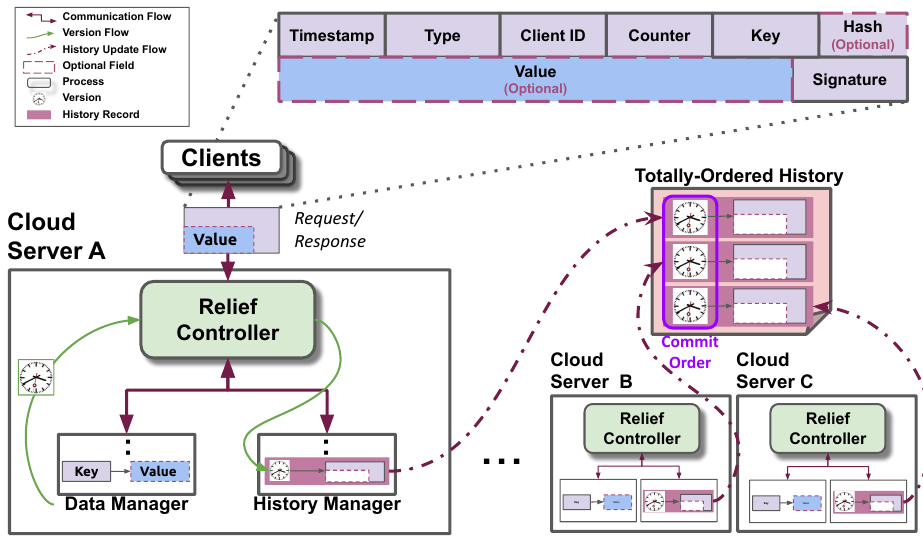
Figure 7. Relief